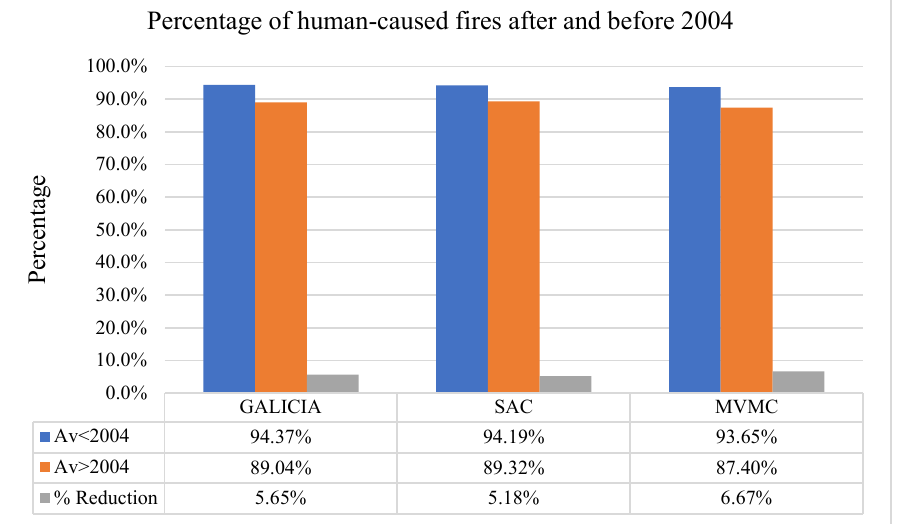
Figure 10. Percentage of human-caused forest fires in the territorial units of study for the period 1999–2014. Shown are the mean value of human-caused fires before (blue colour) and after 2004